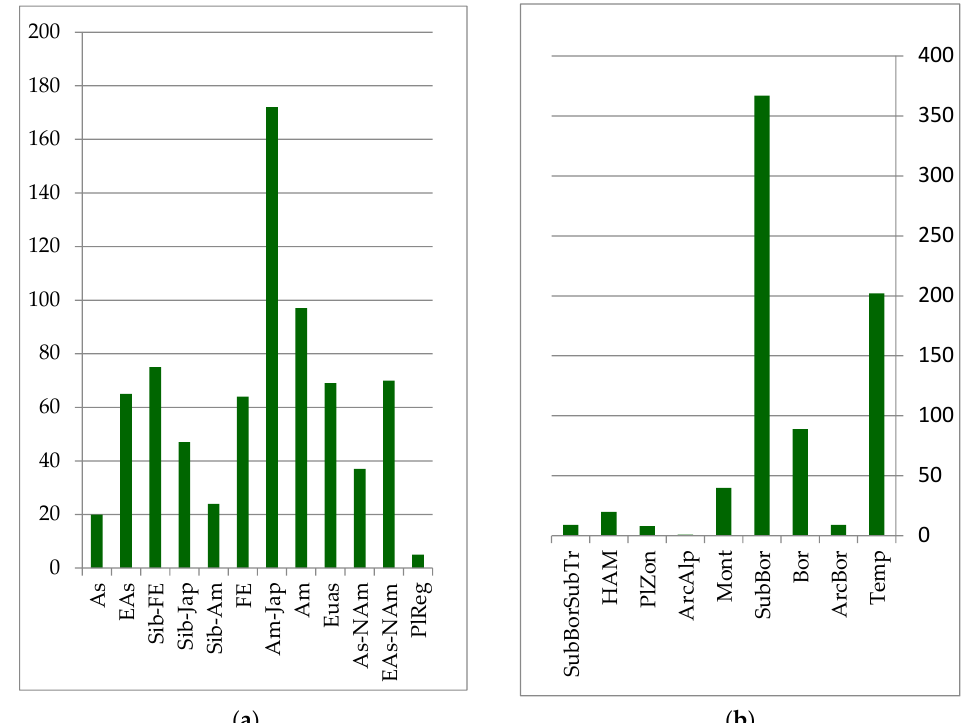
Figure 2. Number of species groups of the forest floristics complex: ( a ) longitudinal species groups: Asian (As); Eastern Asian (EAs); Siberian – Far Eastern (Sib-FE); Siberian – Japanese (Sib-Jap); Siberian – Amurense (Sib-Am); Far Eastern (FE); Amurense – Japanese (Am-Jap); Amurense (Am); Eurasian (Eas); Asian – North American (EAs-Nam); Eurasian – North American (Eas-NAm); PlReg – pluriregional; ( b ) zonal species groups: temperate (Temp); arcto – boreal (ArcBor); boreal (Bor); sub-boreal (SubBor); montane (Mont); arcto – alpine (ArcAlp); plurizonal (PlZon); hypoarcto – montane (HAM); sub-boreal – sub-tropical (SubBorSubTr).